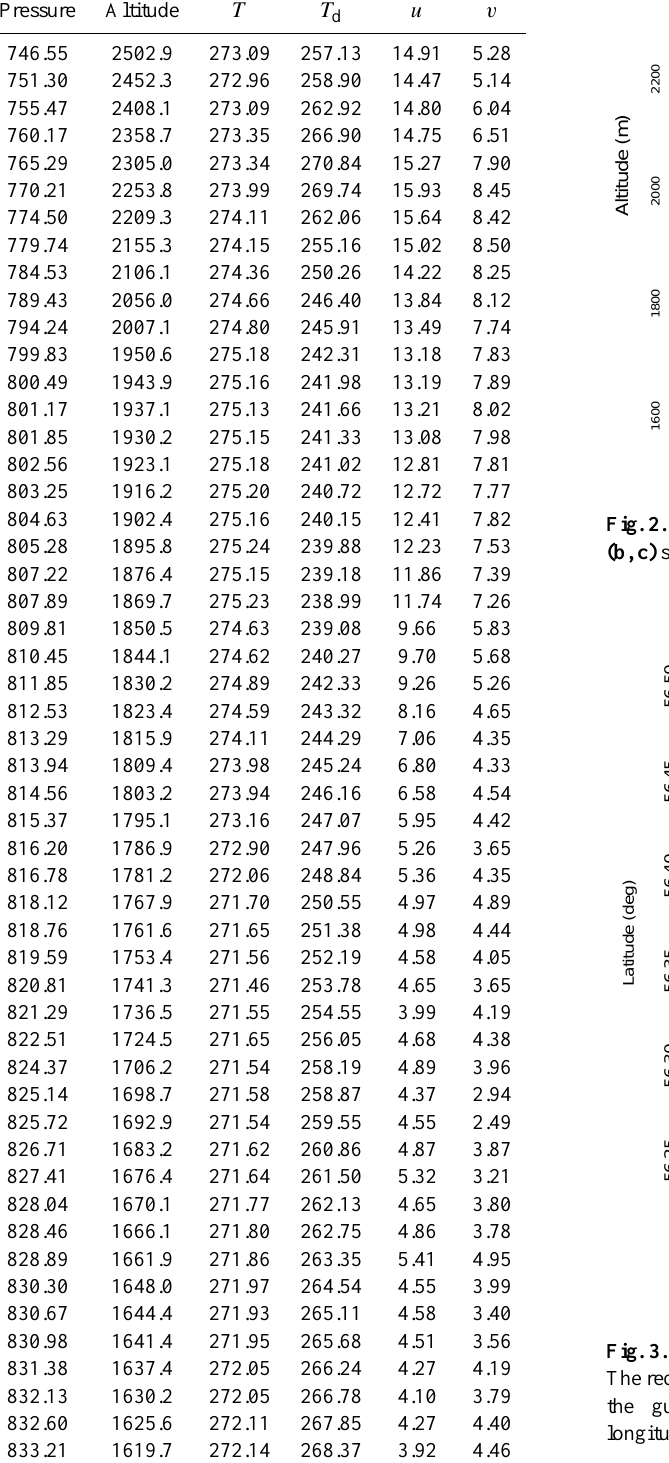
Table 1. Profiles of pressure (hPa), height (m), temperature (K), dew-point temperature T d (K), u and v (ms − 1 ).